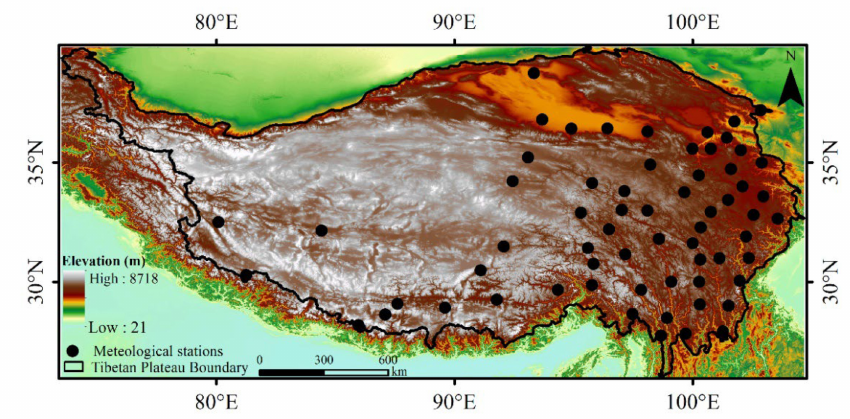
Figure 1. The distribution of the meteorological stations on the Tibetan